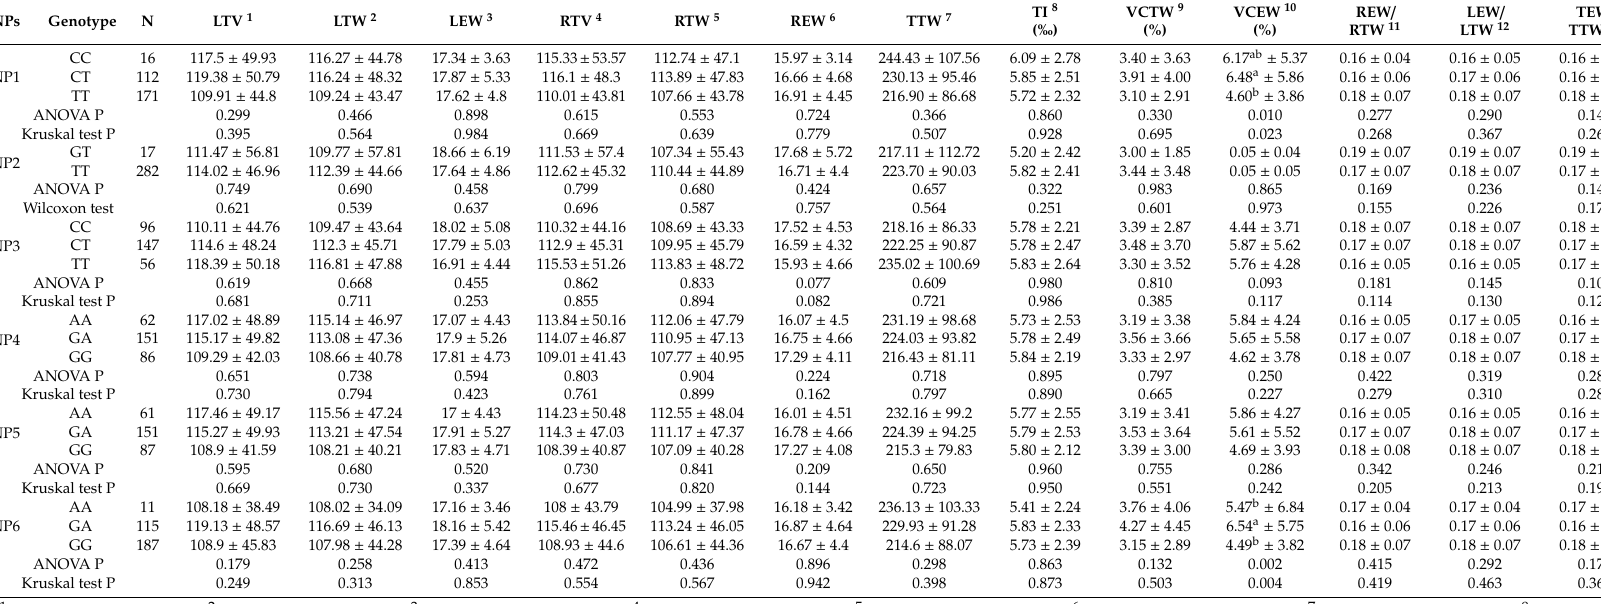
index; 9 variation coe ffi cient between left and right testis weight; 10 variation coe ffi cient between left and right epididymis weight; 11 right epididymis weight / right testis weight; 12 left epididymis weight / left testis weight; 13 total epididymis weight / total testis weight.